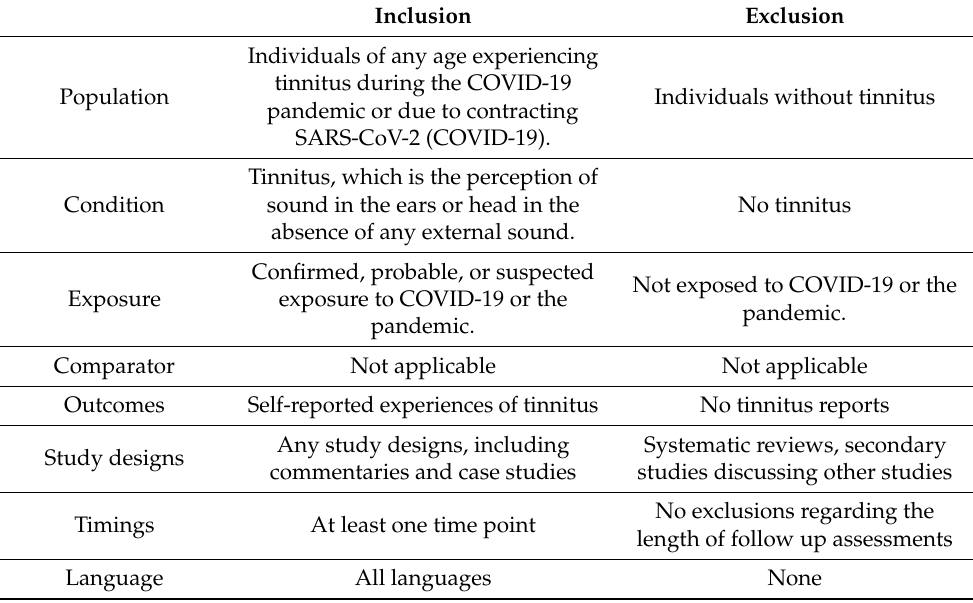
Table 1. Inclusion and exclusion criteria for the